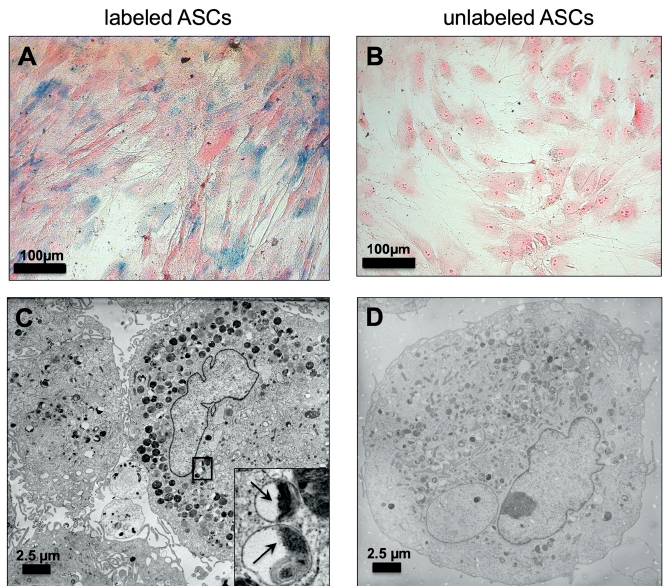
Figure 1. Detection of VSOP-labeled hASCs: Prussian Blue staining of human adipose tissue-derived stromal cells (hASCs) labeled with 1.5 mM citrate-coated very small superparamagnetic iron oxide particles (VSOPs): ( A ) Intracellular blue spots indicate the uptake of iron oxide particles into the hASCs. ( B ) No blue staining was detected in unlabeled controls. Magnification ×200; scale bars represent 100 µm. Transmission electron microscopy (TEM) image analysis: ( C ) Intracellular distribution of vesicles containing VSOPs in hASCs after labeling with 1.5 mM VSOPs. The insert shows individual vesicles at higher magnification with intravesicular VSOPs highlighted by black arrows. ( D ) Within the unlabeled hASCs, no intracellular deposition of VSOPs was detected. Scale bars represent 2.5 µm. hypointense, dark spots, confirmed the presence of VSOPs-labeled cells in the gels (Figure 2A) with lower average signal intensity in the gels with higher VSOPs concentration. Control agarose gel phantoms with unlabeled hASCs showed only single hypointense spots due to microscopic air bubbles (Figure 2B).